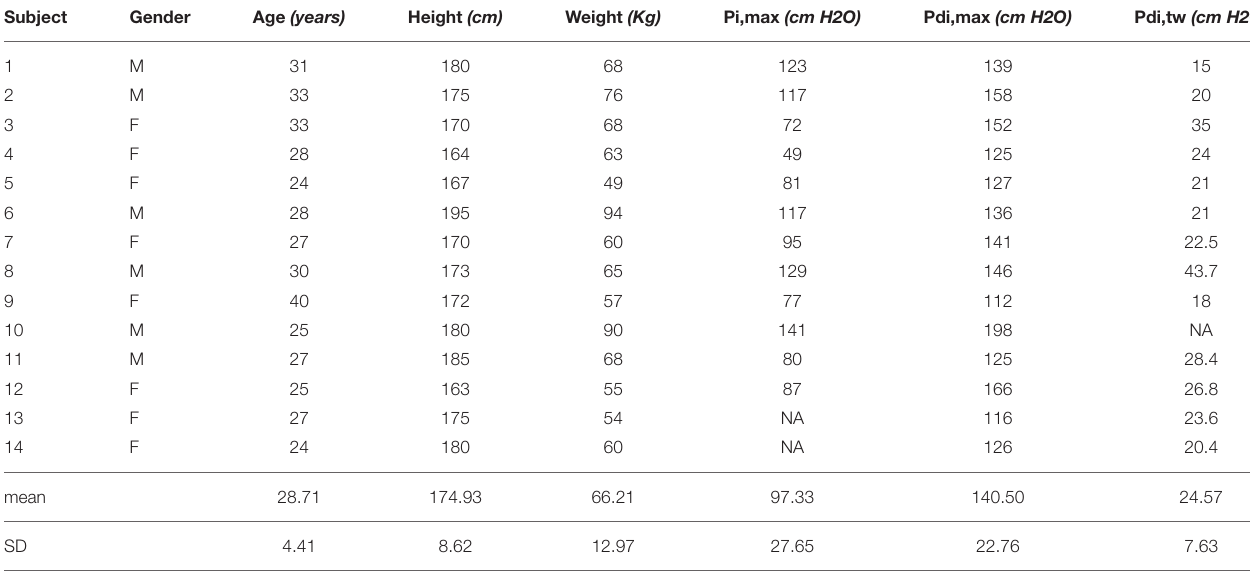
TABLE 1 | Subject characteristics and inspiratory pressure